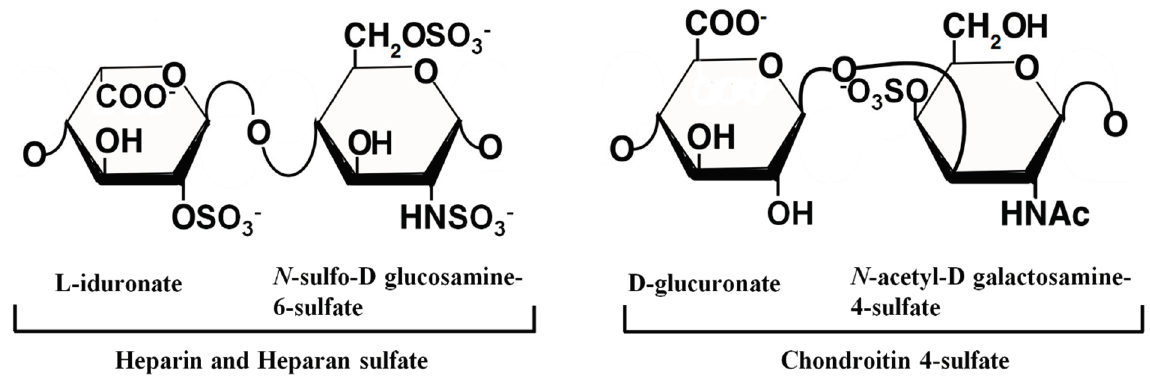
Figure 2. GAGs are highly negatively charged molecules, with extended conformation consisting of disaccharide repeating subunits. The disaccharide units of heparin contains N -acetylglucosamine (GlcNAc) and an uronic acid such as glucuronate or iduronate. Most glucosamine residues are bound in sulfamide linkage. Sulfate is also found on C-3 or C-6 of glucosamine and C-2 of uronic acid. HS contains the same disaccharide units as heparin except some glucosamine are acetylated and there are fewer sulfate groups. The disaccharide unit of CS contains N -acetylgalactosamine with sulfate on either C-4 or C-6 and